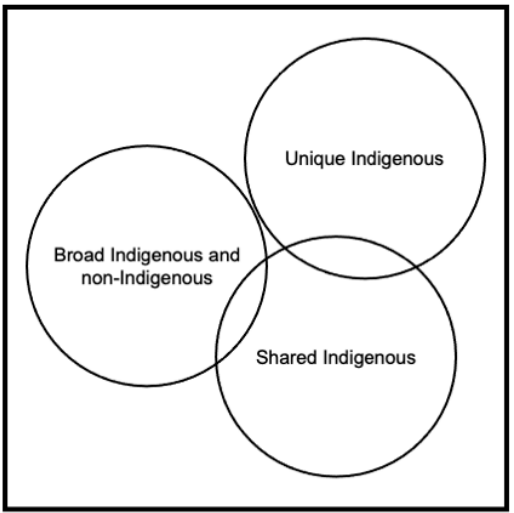
Figure 1. Determinants of Collective Health and Well ‐ being in US Indigenous Communities. Unique determinants are particular to each Indigenous nation, such as culture, use of natural resources for health and healing, traditional practices and ceremonies, and lan ‐ guage. Shared determinants include resilience; relationships with ancestors and future generations; the interconnectedness of determinants and health and well ‐ being; relation ‐ ality; an orientation toward the collective; the individual’s role in the collective; interde ‐ pendence; the importance of and relationships with ancestral and other lands, place, and space; the significance of elders; the intergenerational transmission of traditional knowledge; the changing meaning of health over the life course; nation self ‐ determination and sovereignty; and colonization [9–12,34–38,41,70]. Broad determinants include those identified by the WHO and others as playing a role in creating the environments where people grow, live, and age, such as governance, com ‐ munity cohesion, jobs, health, and other services [16,18]. Figure 1 also elucidates the relationships between the three categories and health and well ‐ being viewed holistically. Unique and shared determinants may overlap. A common environmental context may influence health and healing in many nations that exist in a shared ecosystem, e.g., sage grows in the desert, and many but not all Indigenous nations use sage. Cultures or languages are shared among a few nations, but not all. Shared and broad determinants also overlap. Mainstream broad determinants, e.g., governance, com ‐ munity cohesion, jobs, health, and other services, while applicable, may be conceptualized and measured differently for Indigenous communities. The framework in Figure 1 is not prescriptive. However, it represents a process that establishes community ‐ driven concep ‐ tions of health and well ‐ being. As it begins with locally defined health and well ‐ being, the framework supports a course of action that incorporates partnerships and collaborations to identify unique, nation ‐ based determinants; defines shared determinants that drive comparison and innovation among Indigenous nations; and employs or adjusts broad de ‐ terminants to allow comparisons across Indigenous nations or with other US populations. The schematic in Figure 1 utilizes Indigenous knowledges, cultures, and epistemologies to co ‐ create with Western ideas, community ‐ driven, nation ‐ based theories of health and its determinants.